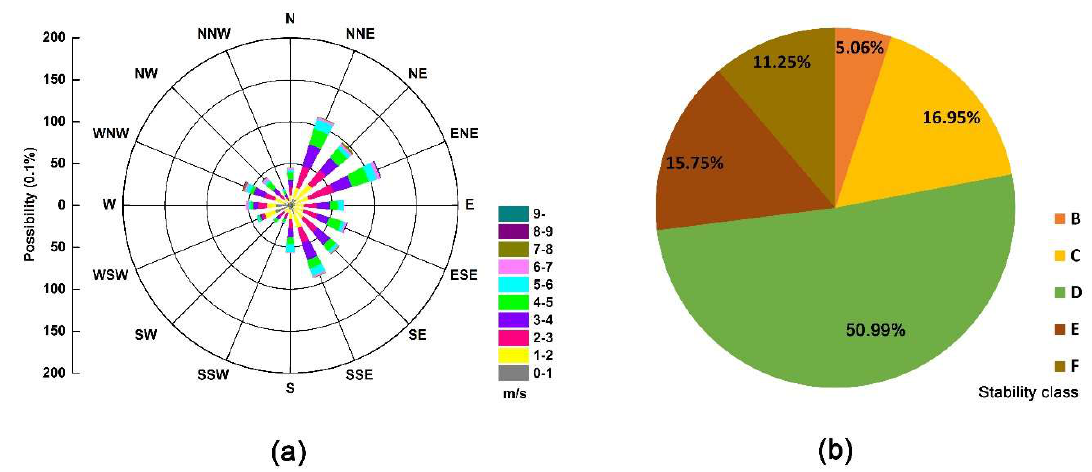
Figure 2. Meteorological conditions for the study area. ( a ) Joint frequency distributions of wind direction and speed and ( b ) frequency distribution of atmospheric stability.